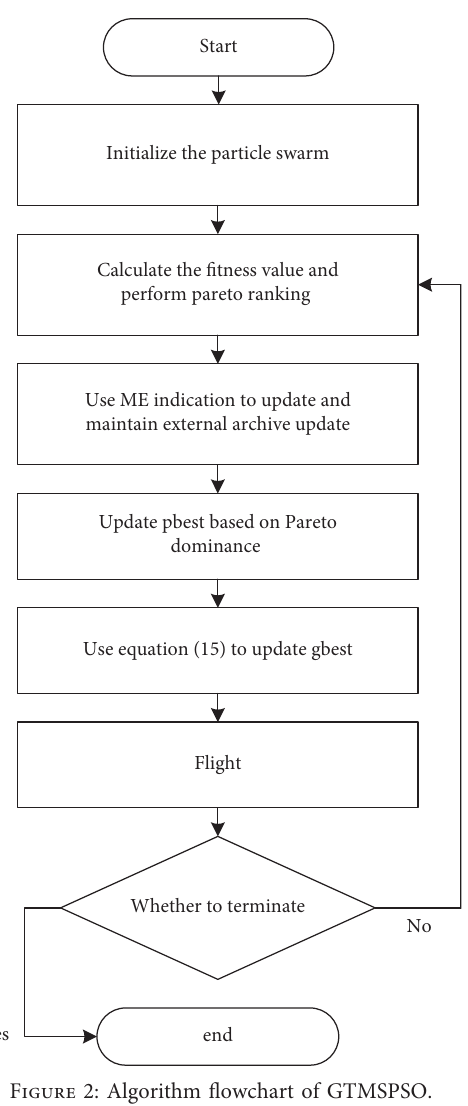
Figure 2: Algorithm flowchart of GTMSPSO.